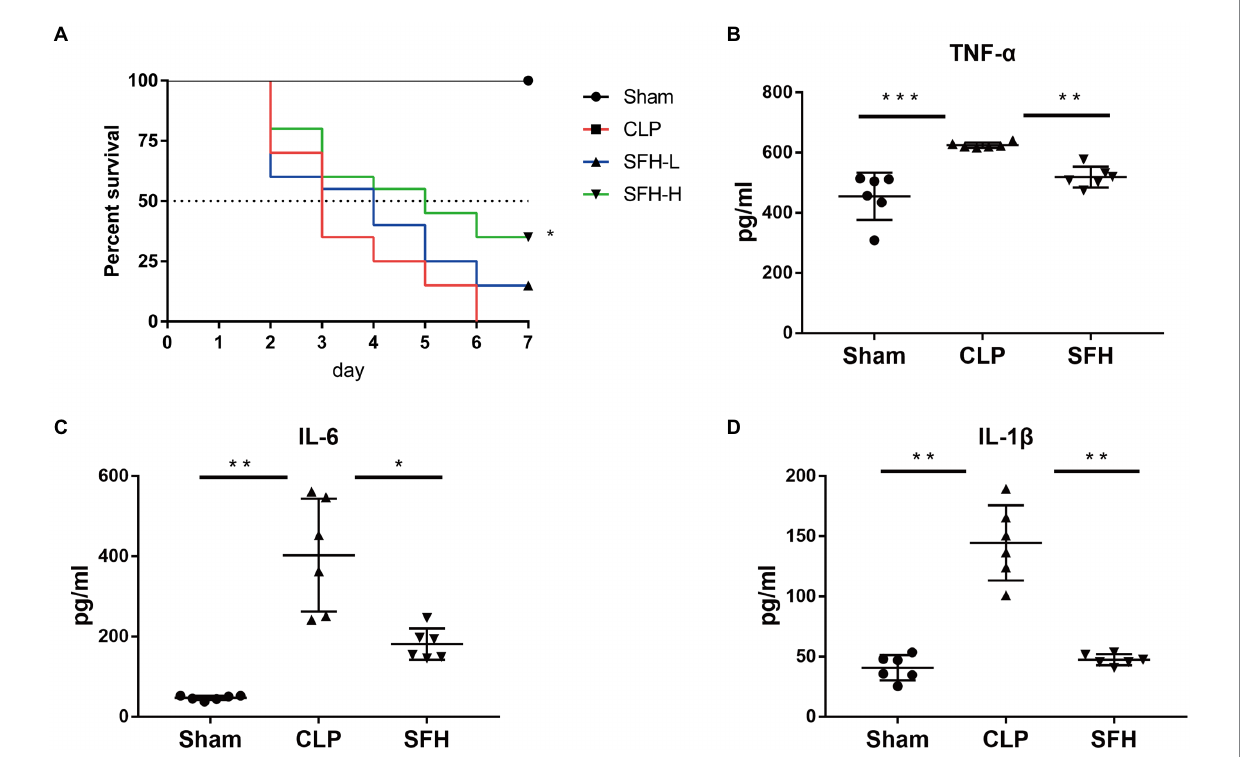
FIGURE 2 Effect of SFH on survival rate and the inflammatory cytokines expression of the septic mice. (A) Kaplan–Meier survival curve analysis of the survival rate. Sham group ( n = 10), CLP, SFH-L, and SFH-H (24 h after operation, n = 20 per group) groups. (B–D) Expression of inflammatory cytokines in serum. Sham, CLP, and SFH ( n = 6 per group) groups. Data were presented as means ± SD, * p < 0.05, ** p < 0.01, *** p <